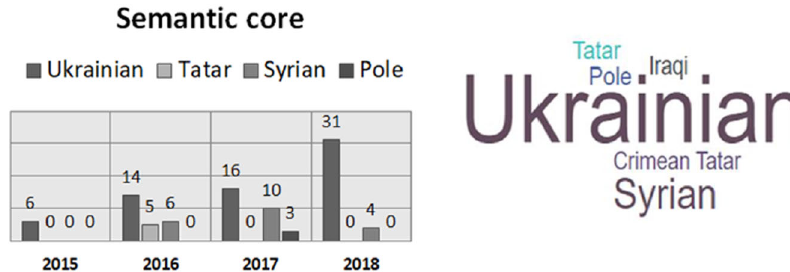
Fig. 3 Semantic core for ethnonyms in the Ukrainian top media discourse (2015 – 2018, sample from every February messages). Source: L. Yuzva ’ s elaboration based on qualitative content analysis (by L. Yuzva and A. Tashchenko) and semantic analysis (by L. Yuzva) of media messages. Data source: The Center for Content Analysis research based on quantitative media content analysis, 2019. The bar chart leftward reports the frequency of mentions of ethnonyms in media messages on migration and migrants. Ukrainians (moderately gray), Syrians (gray), Tatars (light gray), and Poles (dark gray) were mentioned most often. The ‘ word cloud ’ rightward illustrates the frequency of mentions of different ethnonyms: the larger the font, the more often the name was mentioned. The colors of the ‘ word cloud ’ do not have a semantic load and are conditioned by the settings of the visualization